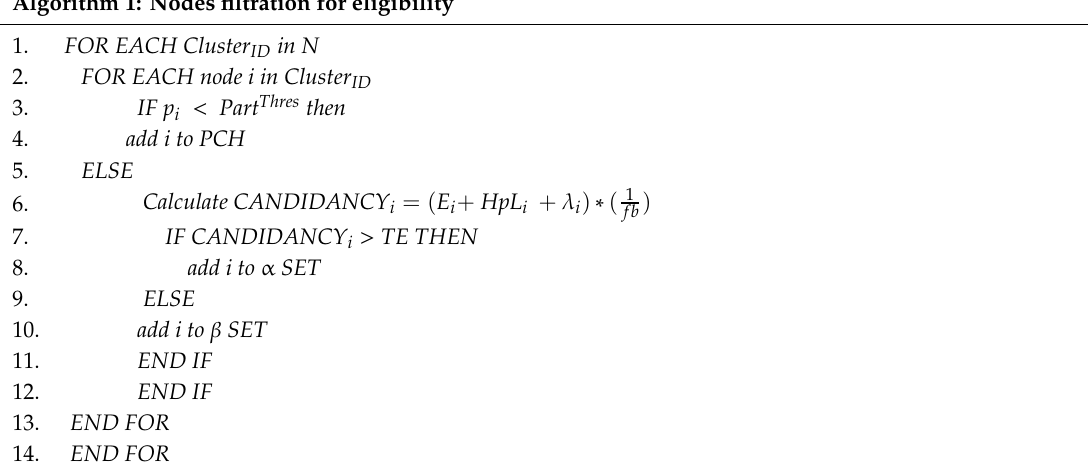
Algorithm 1: Nodes filtration for